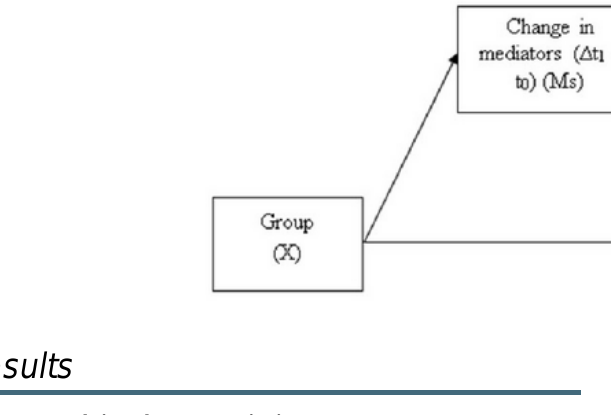
Figure 3. Differences between baseline (t 0 ) and the 2-week post-treatment (t 1 ) and the 4-week follow-up (t 2 ) assessments were calculated as standardized residualized change scores. Group was defined as experimental (internet-based behavioral activation) vs the pooled control groups (internet-based mindfulness intervention and care as usual). Mediators were measured using the Behavioral Activation for Depression Scale, Kentucky Inventory of Mindfulness Skills, and Dysfunctional Attitude Scale (German 18-item version of form B). Depressive symptoms were measured using the Patient Health